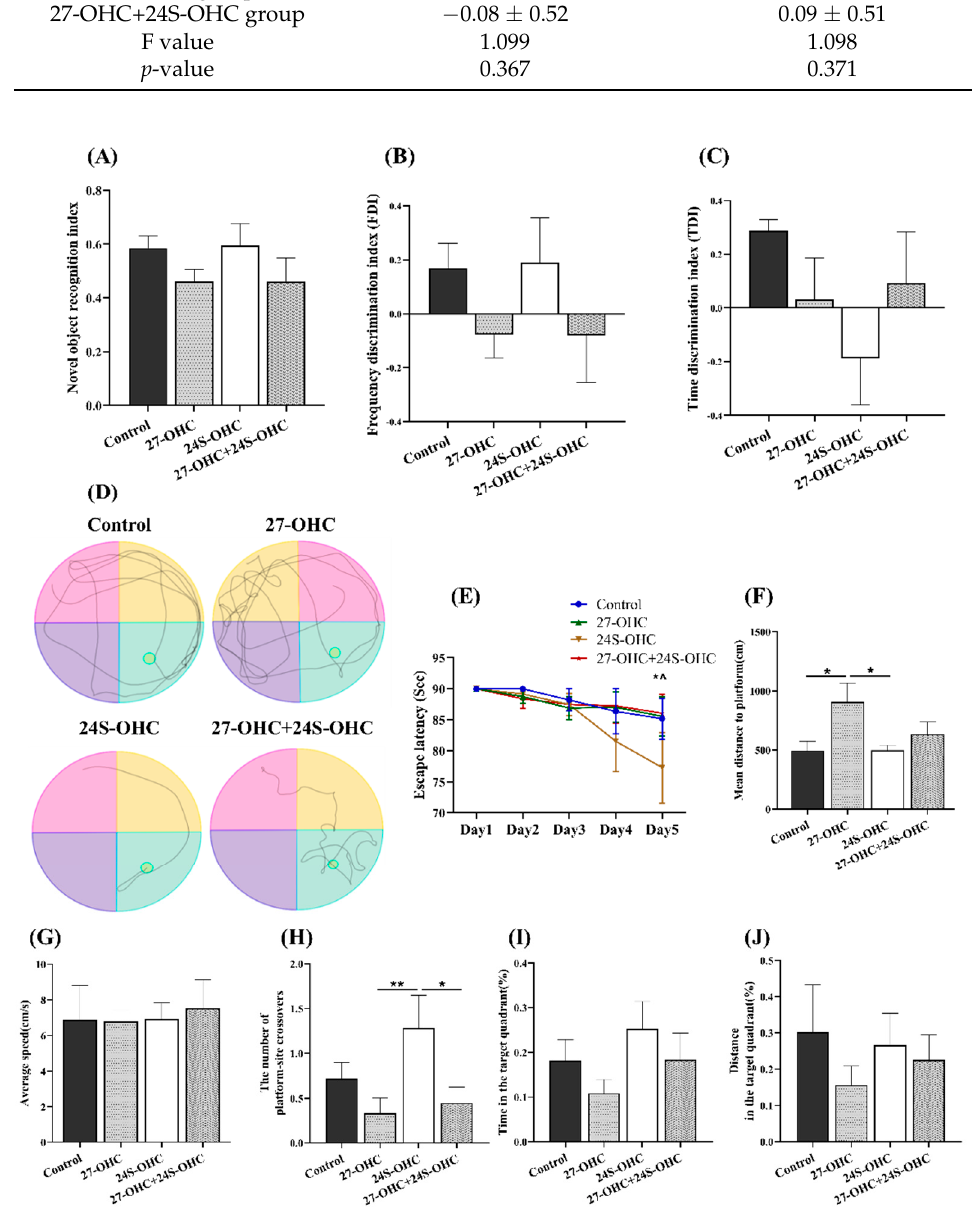
Figure 2. Effects of oxysterols on novel object recognition and Morris water maze test ( n = 10, mean ± SEM). ( A ) Novel object recognition index (NORI); ( B ) frequency discrimination index (FDI); ( C ) time discrimination index (TDI); ( D ) swimming path; ( E ) escape latency, *: 24S-OHC group: Day1 VS Day5, p < 0.05, ^: 24S-OHC group: Day2 VS Day5, p < 0.05; ( F ) mean distance to platform; ( G ) average speed; ( H ) the number of platform-site crossovers; ( I ) time in the target quadrant (%); ( J ) distance in the target quadrant (%). *: p < 0.05, **: p < 0.01.